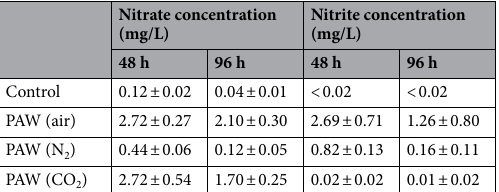
Table 3. Concentration (mg/L) of nitrates and nitrites in the irrigation PAWs collected after 48 h and 96 h of seed germination.